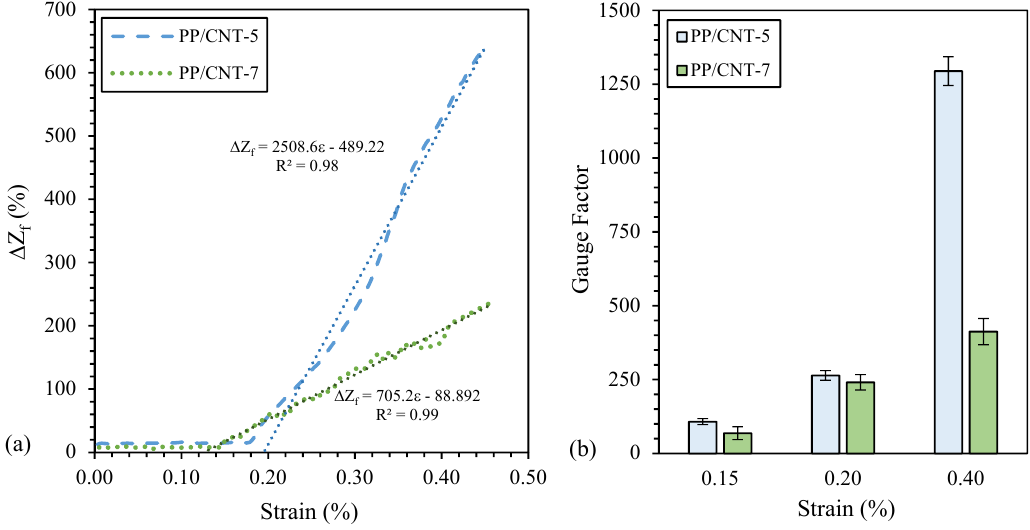
Figure 12: Impedance value for PP/CNT ‐ 7 nanocomposites. (a) Impedance (Z) variation vs. load and (b)